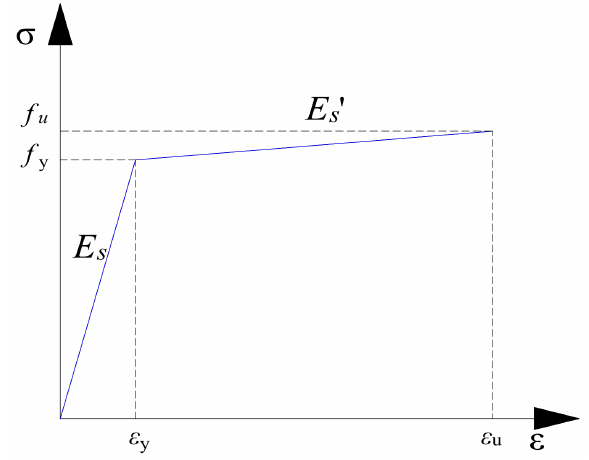
Figure 15. Stress-strain curve of